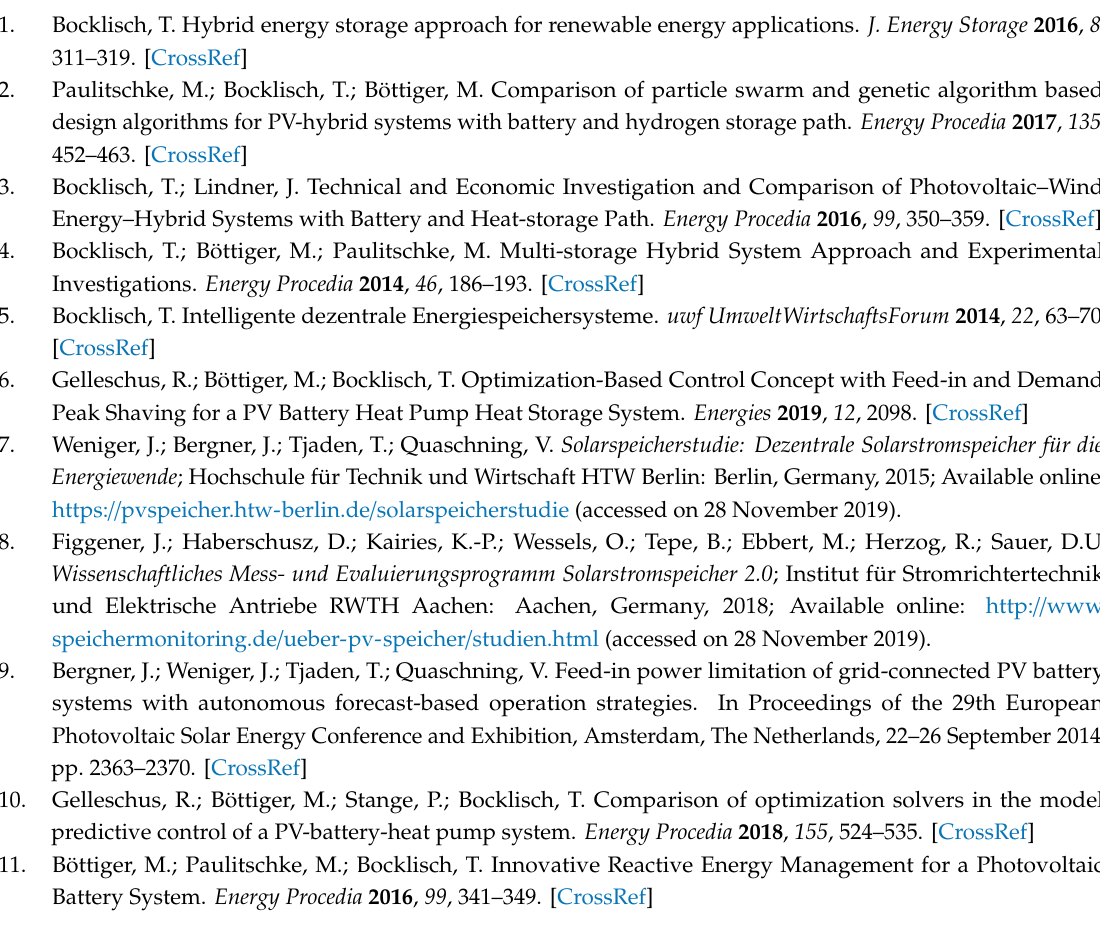
Figure B2. Individual degrees of self-consumption and neighborhood feed-in ratios for all households